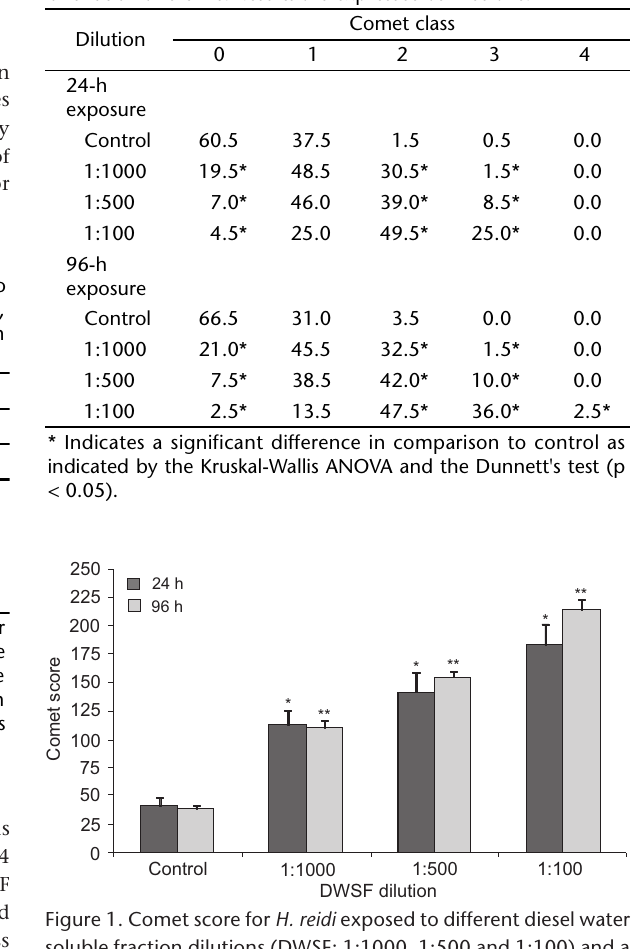
Table II. Damage frequency of erythrocytes of H. reidi exposed to different diesel water soluble fraction dilutions (DWSF: 1:1000,